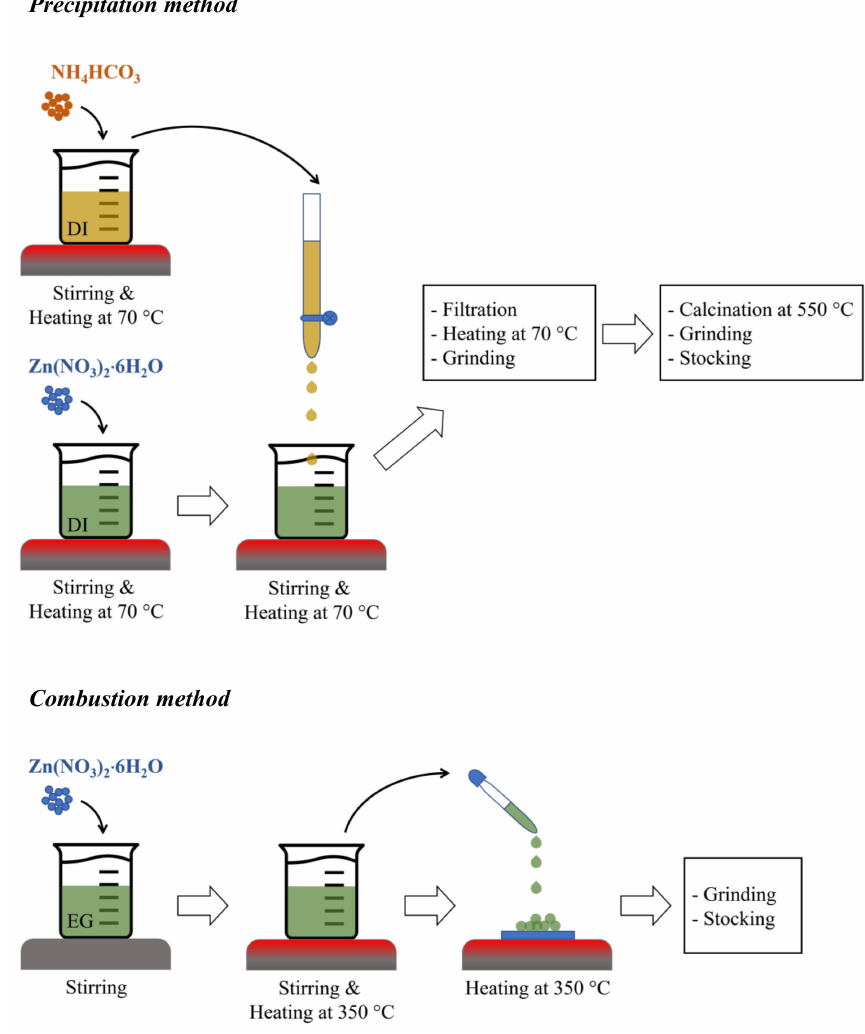
Figure 1. The illustration of ZnO preparation via precipitation and combustion methods. In the photocatalytic activity test, the produced ZnO NPs via precipitation and com- bustion were utilized as photocatalysts for MB degradation. The starting MB solution was prepared by dissolving 5 mg of MB in 1 L of DI water (pH ~ 6.93). It was then stirred in the dark for 1 h. The solution was divided into two beakers, each containing 100 mL. Each beaker was loaded with a portion of 0.1 g of the ZnO NPs and stirred for 10 min in the dark. The mixtures were then placed in the photocatalytic activity station and left for 30 min in the dark to reach adsorption-desorption equilibrium. Afterward, the MB solution contain- ing ZnO NPs was irradiated with UV light (Philips TUV 30W, 3 lamps, Nakhon Pathom, Thailand) to activate the photocatalytic activity. The solutions were sampled to measure absorbance using a UV–VIS spectrophotometer (BioMate 160, Nakhon Pathom, Thailand) and evaluate the photocatalytic activity. Furthermore, the photocatalytic degradation of MB was tested in natural sunlight to demonstrate its effectiveness and